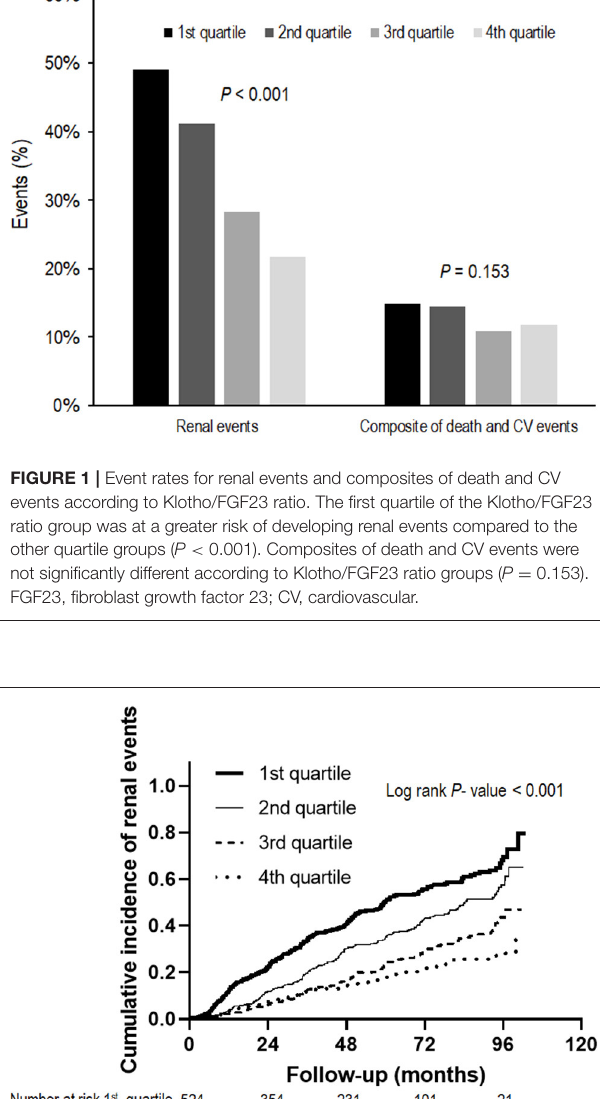
model, the logarithm of the Klotho/FGF23 ratio was inversely associated with the composite of CV events and death (HR: there was no significant association between the Klotho/FGF23 ratio groups and the composite outcome of CV events and death ( Table 3